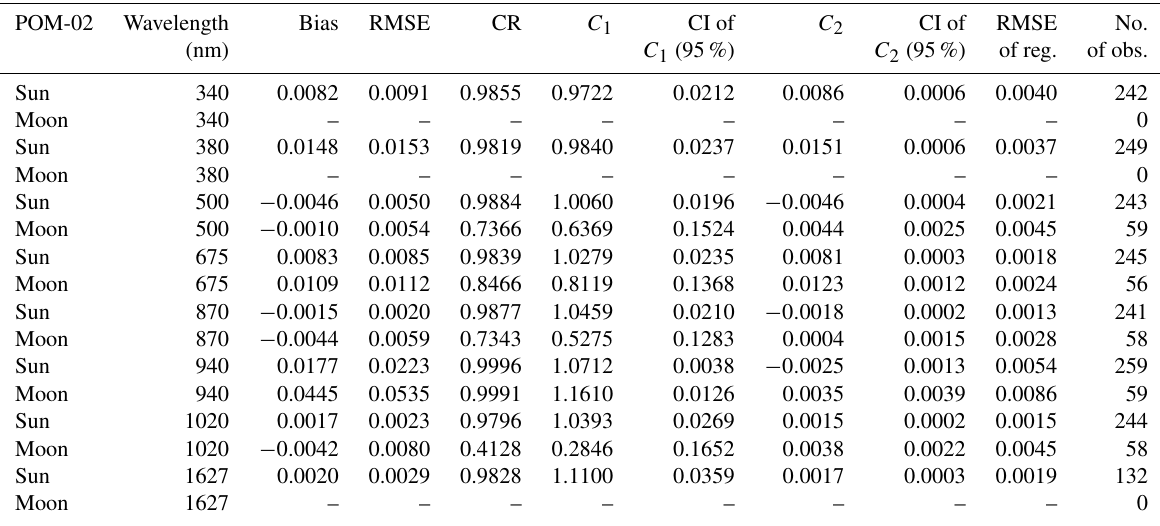
Table 10. Same as Table 4 except for the AERONET and POM-02 aerosol optical depth (precipitable water vapor).